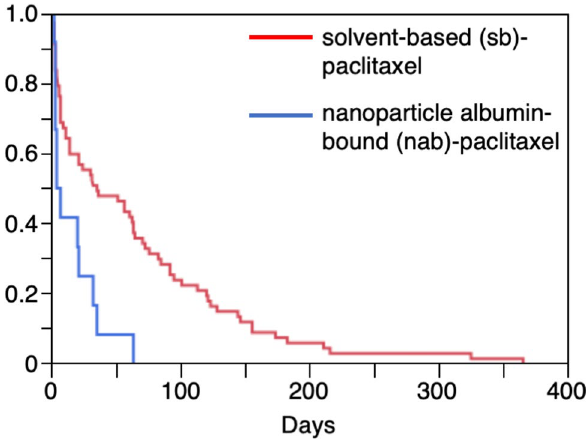
Figure 3. Kaplan–Meier plot of chemotherapy-induced peripheral neuropathy for solvent-based (sb)-paclitaxel and nanoparticle albumin-bound (nab)-paclitaxel.